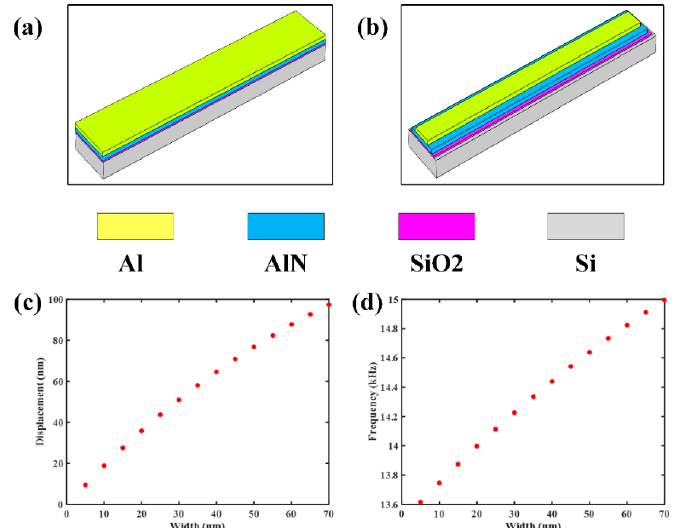
Figure 1. The comparison between the classical equivalent ‐ width beam and the proposed four ‐ layer variable width beam, and four ‐ layer films are Al electrode, AlN piezoelectric layer, silicon oxide (SiO2), and the silicon substrate. ( a ) The geometry of equivalent ‐ width beam; ( b ) the geome ‐ try of proposed variable width beam, the width gradually decreases from bottom to top; ( c,d ) tip displacement and fundamental frequency versus the width of the piezoelectric layer when the piezoelectric bimorph consists of Si with a width of 70 𝜇𝑚 and